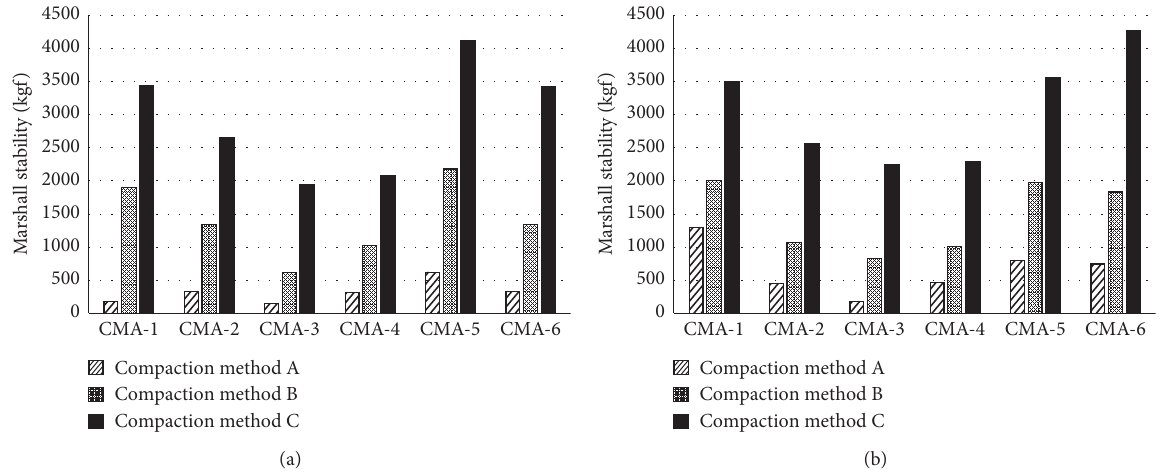
Figure 3: Marshall stability indicating (a) short- and (b) long-term performance.